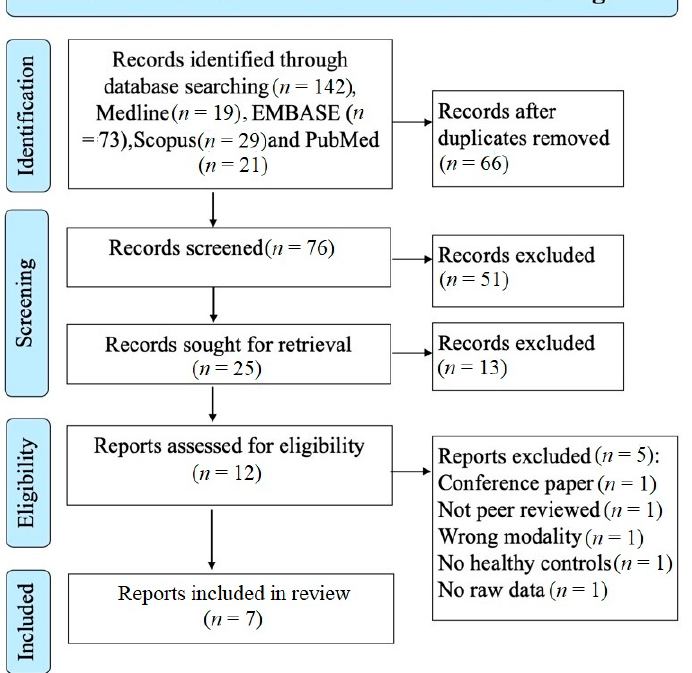
Figure 1. Prisma flow diagram showing the systematic search strategy, study identification, screening, and eligibility and inclusion criteria. Table 1. Demographics and clinical characteristics of the included NODDI studies on MS. Abbreviations: NA = not available; HC = healthy controls; * = mean and standard deviation; -- = not applicable; SD = standard deviation; RRMS = relapsing remitting multiple sclerosis; PPMS = primary progressive multiple sclerosis; and CIS = clinically isolated syndromes.